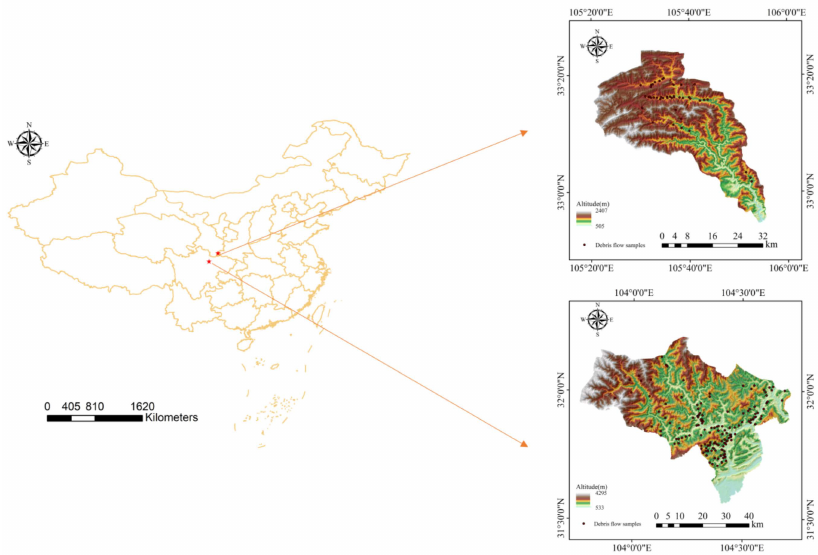
Figure 1. Location of the study areas with debris flows inventory